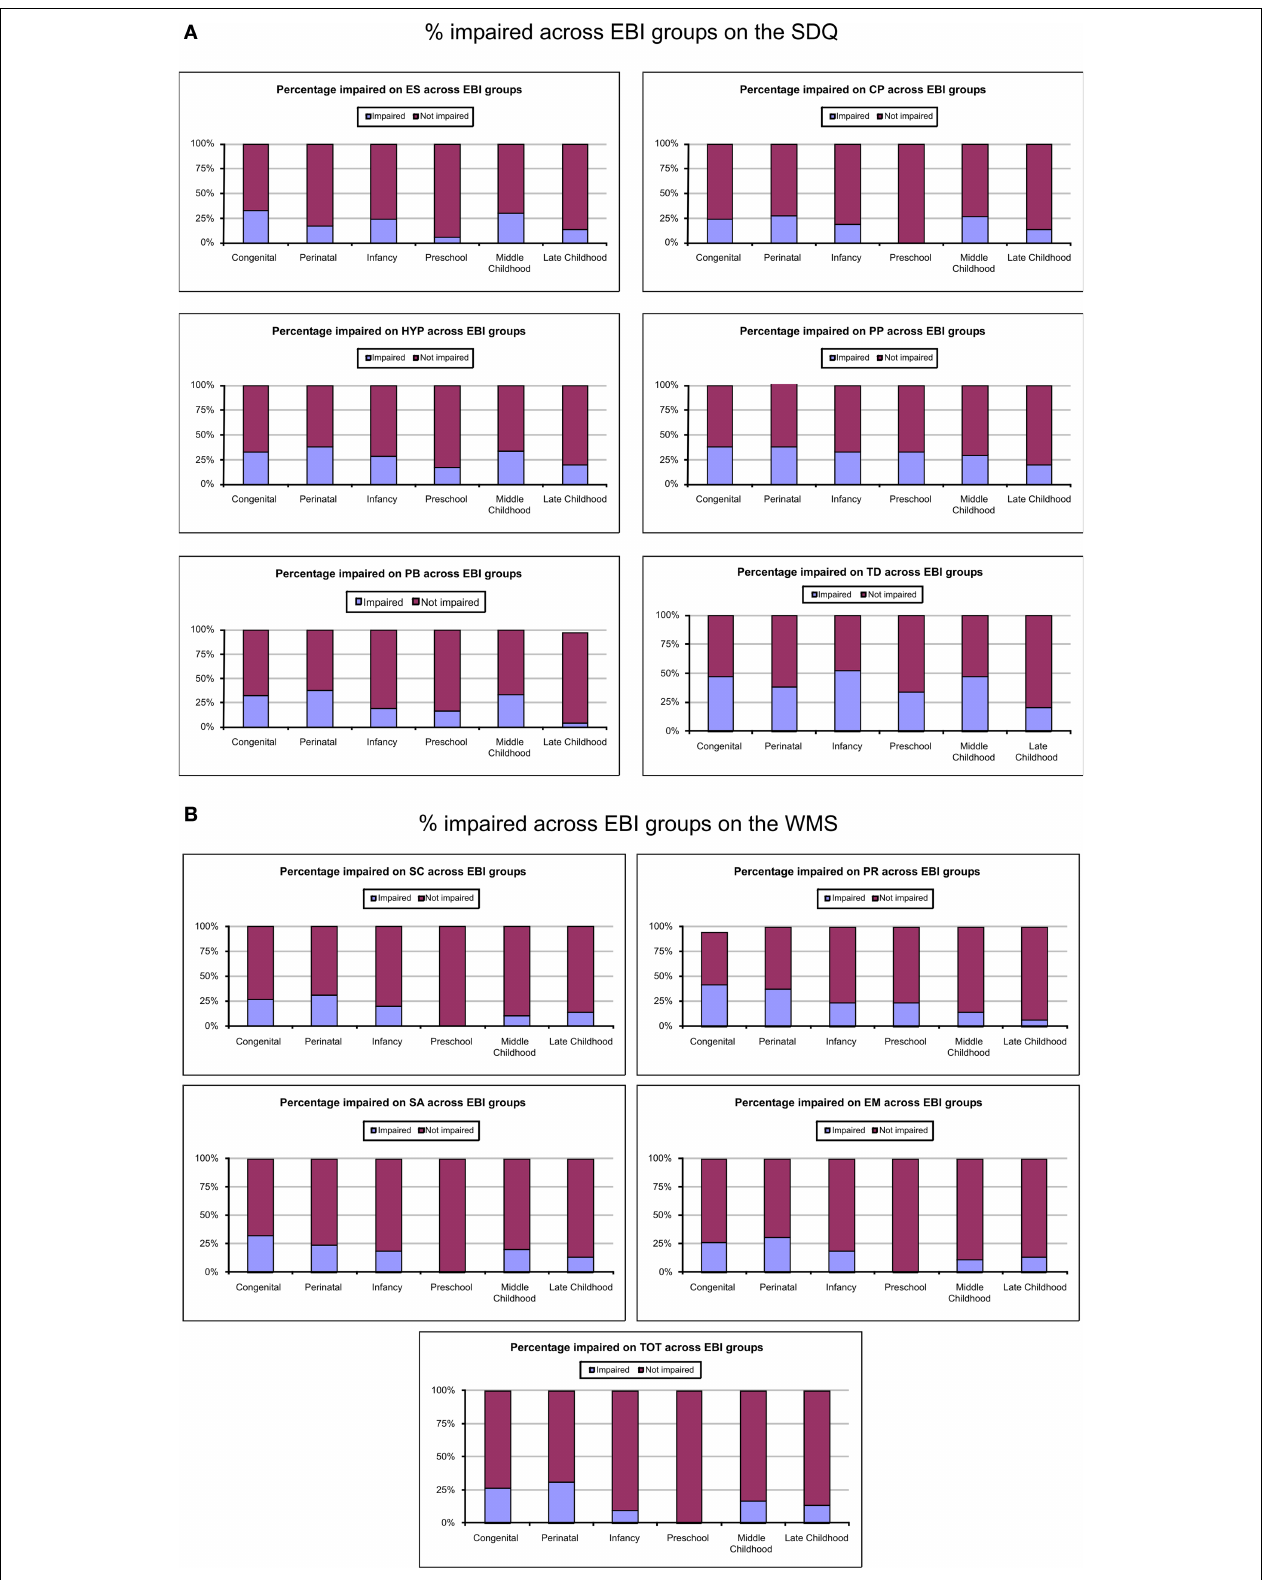
FIGURE 1 | (A) Percentages of children across EBI groups with impairment on the SDQ. (B) Percentage of children across groups identifi ed as impaired on the